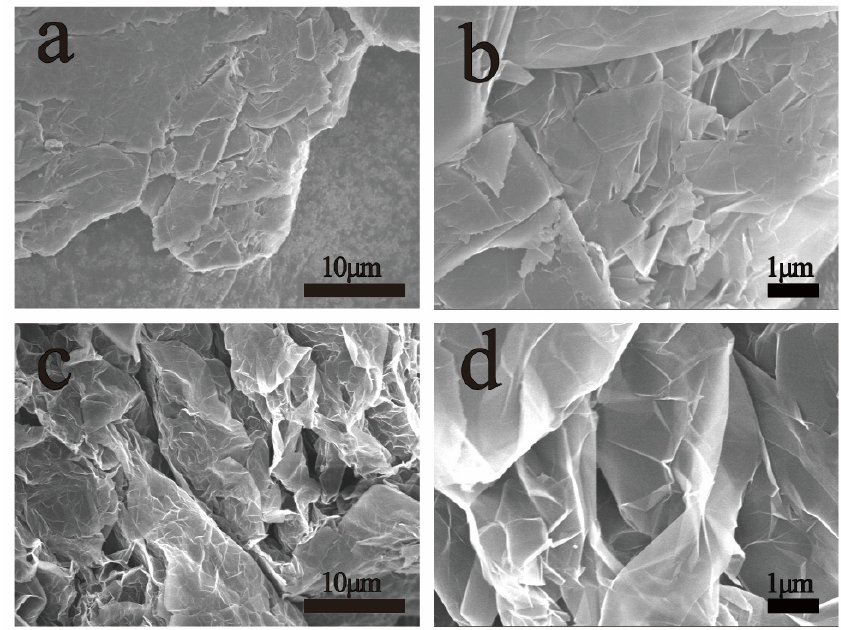
Figure 1. SEM images: ( a ) 10 μ m light of the graphite; ( b ) 1 μ m light of the graphite; ( c ) 10 μ m light of the exfoliated graphite compound; ( d ) 1 μ m light of the exfoliated graphite compound. To determine the thickness and lateral size of the exfoliated graphite compound, the flakes were transferred onto a Si substrate by spin coating for AFM measurements. The AFM image of exfoliated graphite compound is shown in Figure 2a. The exfoliated graph- ~0.7 nm (Figure 2b), corresponding to 1–2 layers (0.4–0.7 nm for a single layer in ref. [29]).